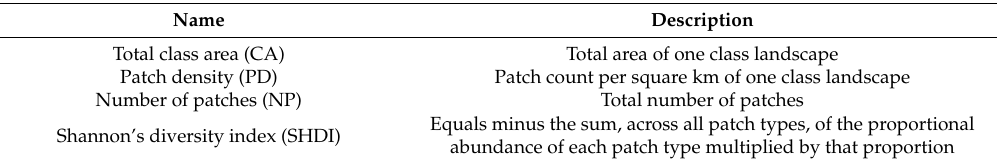
Table 1. Spatial landscape metrics selected in this study.